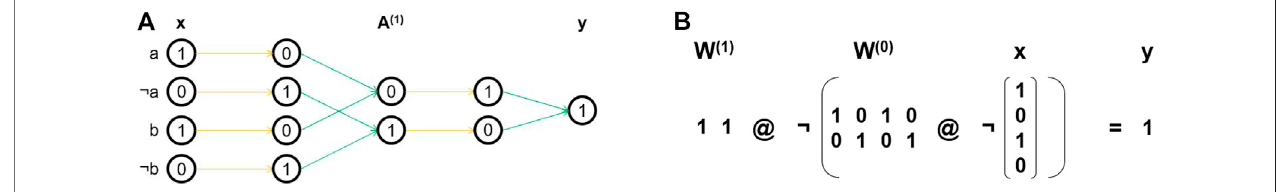
FIGURE 3 | Example network and binary matrix multiplications for the parity concept with two variables, y (cid:1) ( a ∧ b ) ∨ ( ¬ a ∧ ¬ b ). Orange connections are logical negations ( ¬ ), green edges correspond to binary matrix multiplications (@). (A) Activations processed through the network. (B) matrix